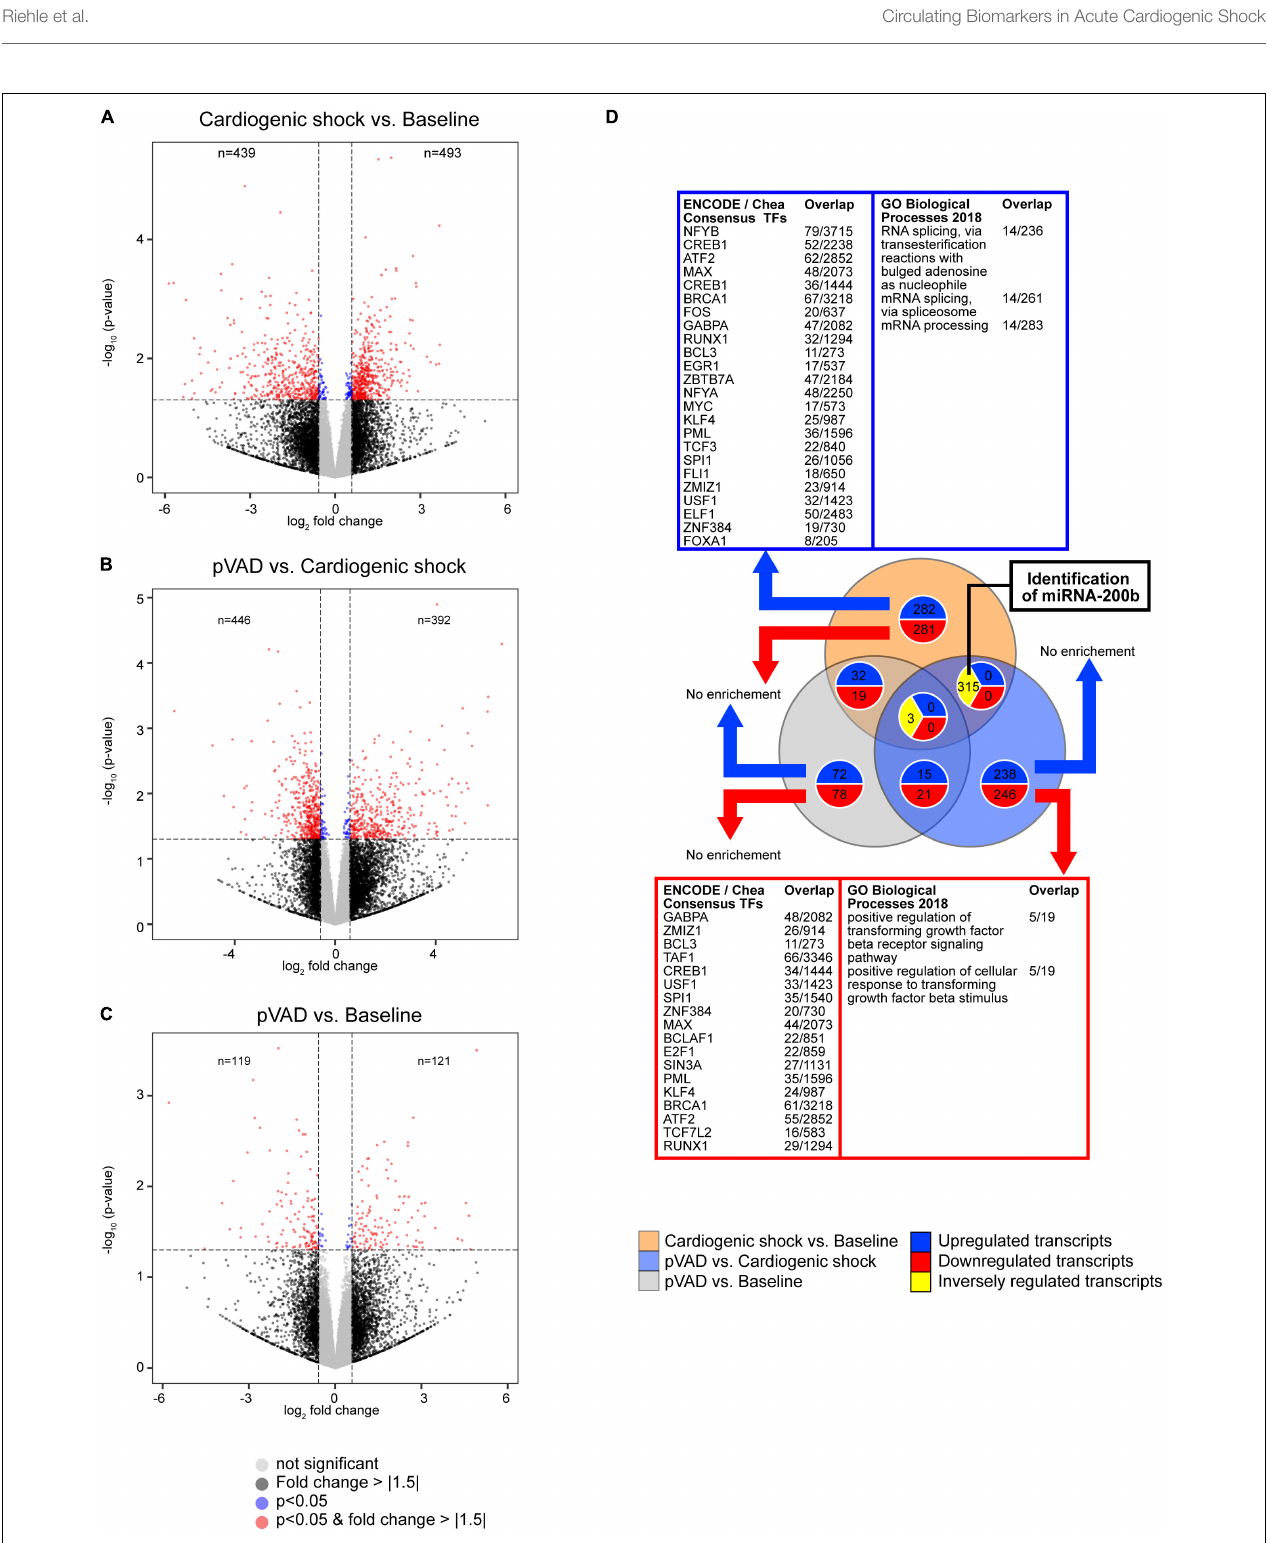
FIGURE 3 | Transcriptional profiling determined by RNA sequencing. Volcano plots for the comparisons (A) Cardiogenic shock vs. Baseline, (B) pVAD vs. Cardiogenic shock, and (C) pVAD vs. Baseline. Volcano plots display the expression level of all transcripts detected. Dashed lines indicate p = 0.05 (equals -log 10 ∼ 1.30) and a | fold change| > 1.5 (equals an absolute log 2 fold change ∼ 0.585). Numbers indicate the number of different expressed transcripts with a | fold change| > 1.5 and p < 0.05. (D) Venn diagram illustrating the number of altered transcripts for the RNA sequencing experiments performed. The number of transcripts presented in the Venn diagram correspond to a | fold change| > 1.5 and p < 0.05. Significantly enriched transcription factors and pathways as indicated ( q < 0.1); pVAD, percutaneous ventricular assist device.